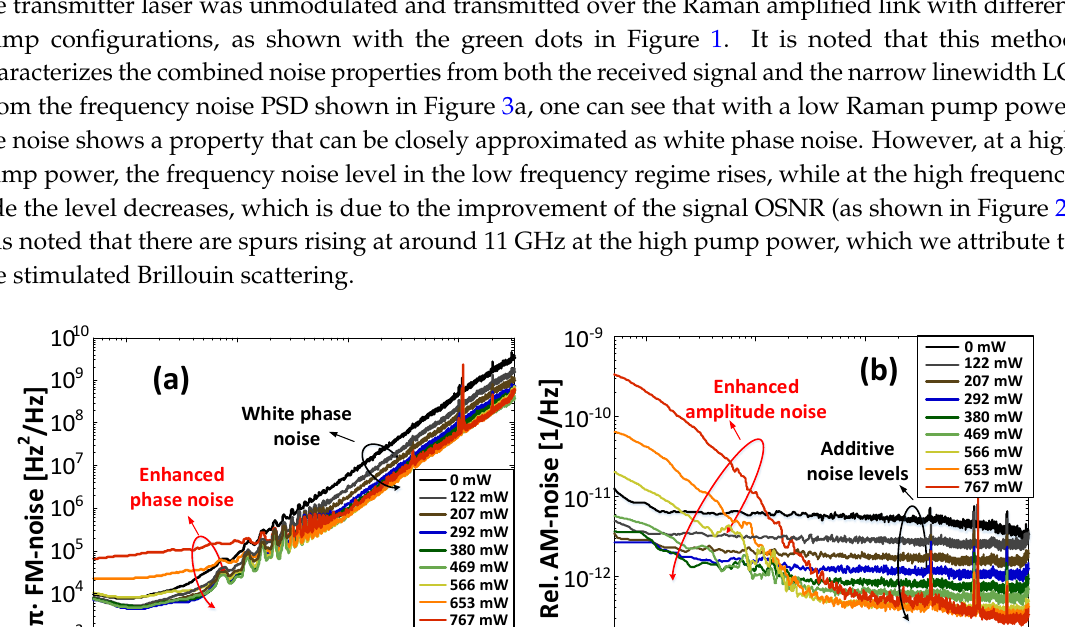
Figure 3. ( a ) Measured frequency noise and ( b ) relative amplitude noise power spectrum density for different pump powers. For all selected cases, the launched power = 5 dBm, fiber length = 200 km.